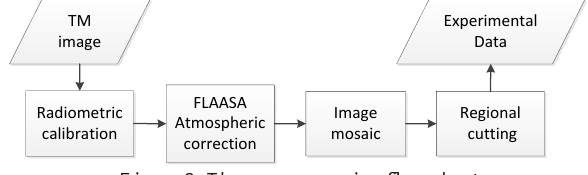
Figure 2. The pre-processing flow chart